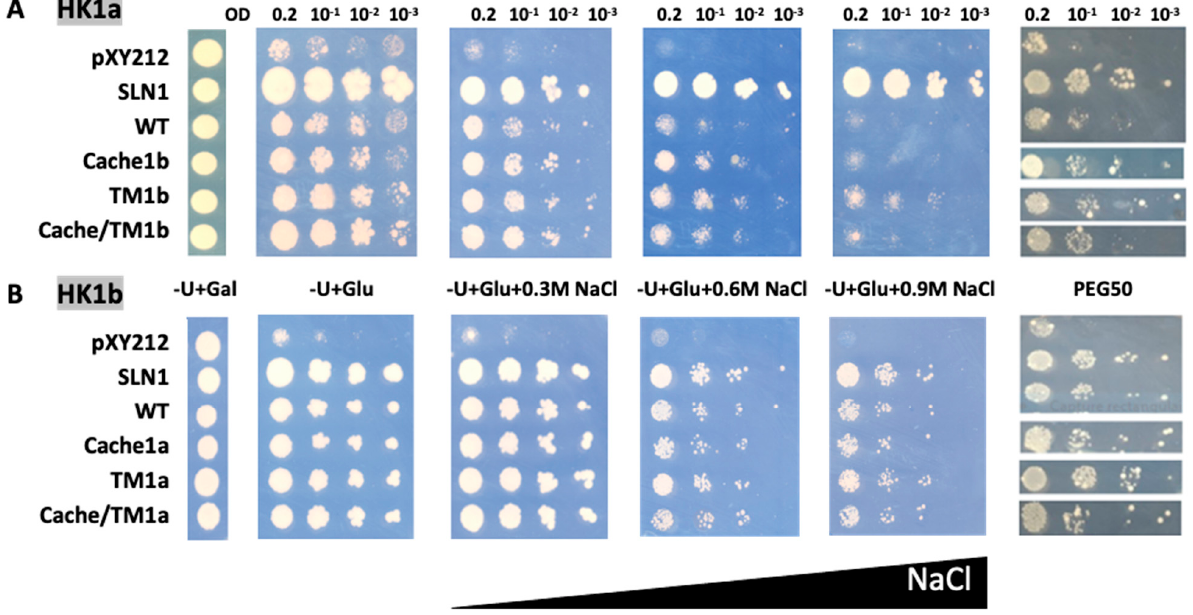
Figure 5. Functional complementation test for TM mutants of HK1a ( A ) and HK1b ( B ) in presence of NaCl or PEG 6000 stresses. The osmodeficient strain (MH179) was transformed with the negative (pYX212 empty vector) and positive (SLN1) controls, as well as with wild type constructs (WT) and single cache domain exchange constructs (HK1a: cache1b residues 121–437 and HK1b: cache1a residues 121–445), TM2 exchange constructs (HK1a: TM1b with F470C mutation and HK1b: TM1a with C478F mutation) or double exchange constructs of HK1a cache/TM1b) and HK1b (cache/TM1a). Transformants were spotted onto galactose containing medium ( − U + Gal) for growth control and onto glucose containing medium ( − U + Glu), without or with increasing NaCl concentrations (0.3, 0.6 and 0.9 M) or infused PEG 6000 50% w / v (PEG50), for osmotic tolerance test. Growth tests are representative of four independent replicates as serial 10-fold dilutions from an OD 600 = 0.2, as indicated.